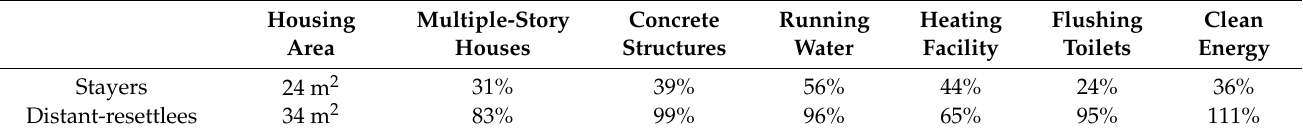
Table 4. The features of housing and